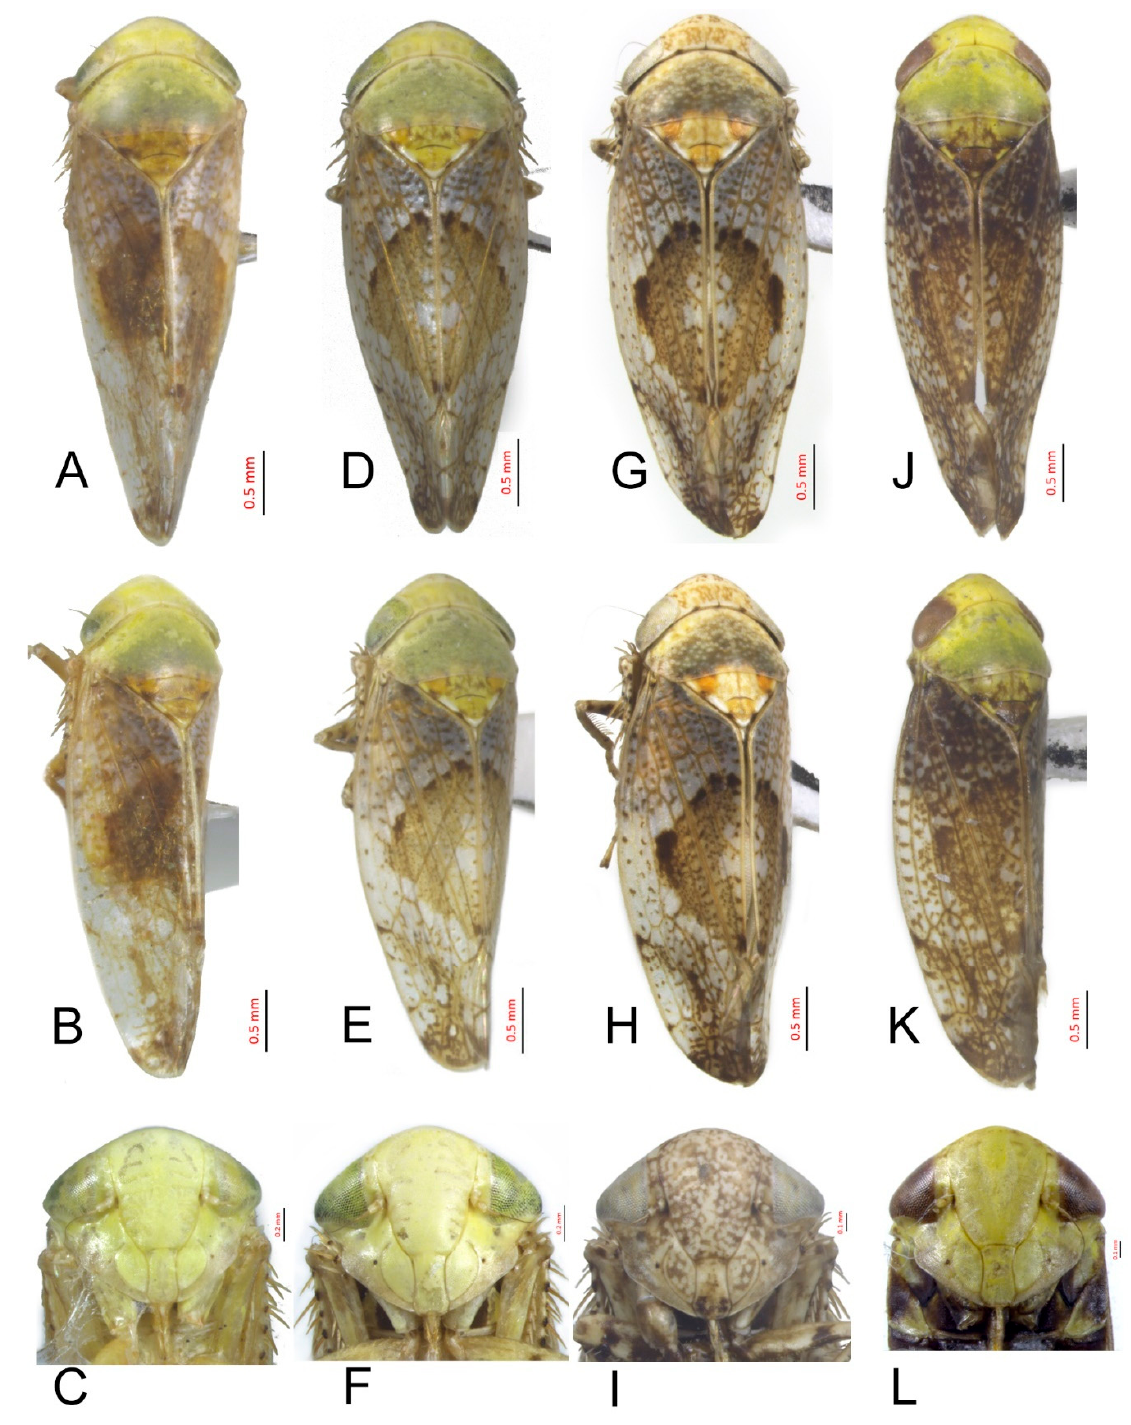
Figure 4. Species of Hishimonus . ( A – C ) H. yuanmouensis ; ( D – F ) H. hamatus ; ( G – I ) H. fuscomaculatus ; and ( J – L ) H. lii . ( A , D , G , J ) Dorsal view; ( B , E , H , K ) latero-dorsal view; and ( C , F , I , L ) Face.